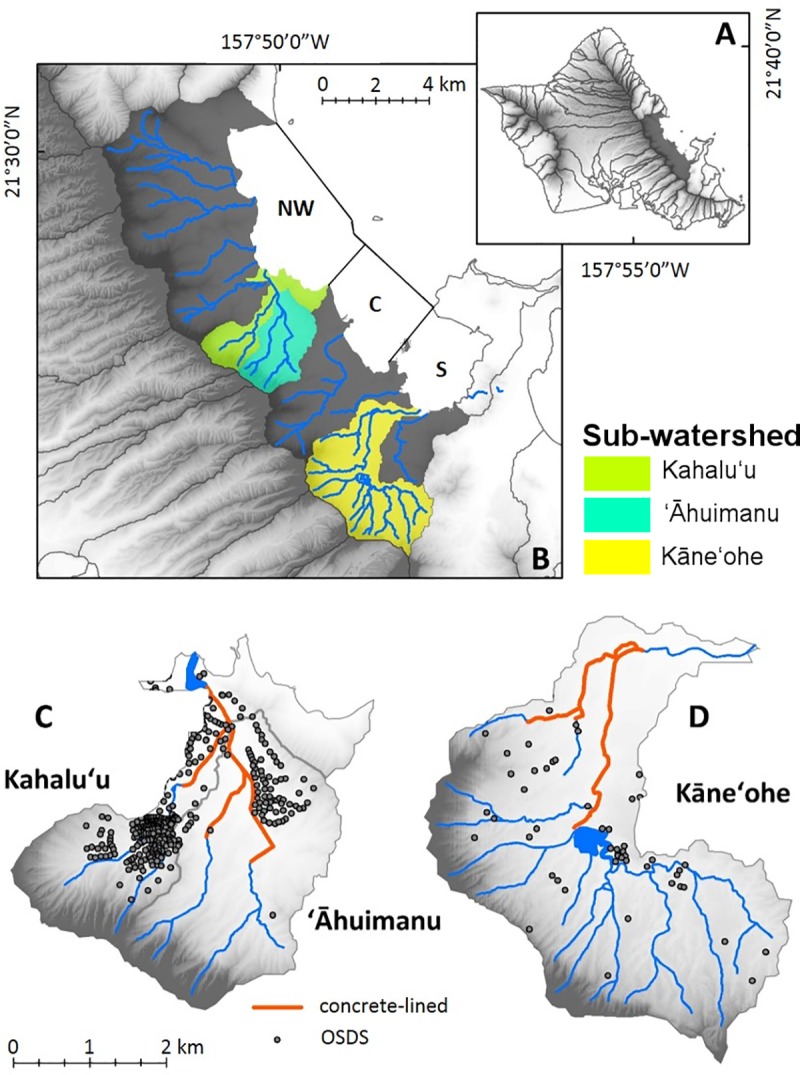
Map of study area.(A) Location of study area on the island of Oʻahu, (B) Sectors of Kāneʻohe Bay (NW, C, and S), Kāneʻohe watershed and streams, and sub-watersheds (Kahaluʻu, ʻĀhuimanu, and Kāneʻohe) studied. Detailed view of (C) Kahaluʻu and ʻĀhuimanu and (D) Kāneʻohe sub-watersheds. Portions of the stream that are lined with concrete are in orange. Each dot represents an individual onsite sewage disposal system (OSDS), which are predominantly cesspools in the region [32].